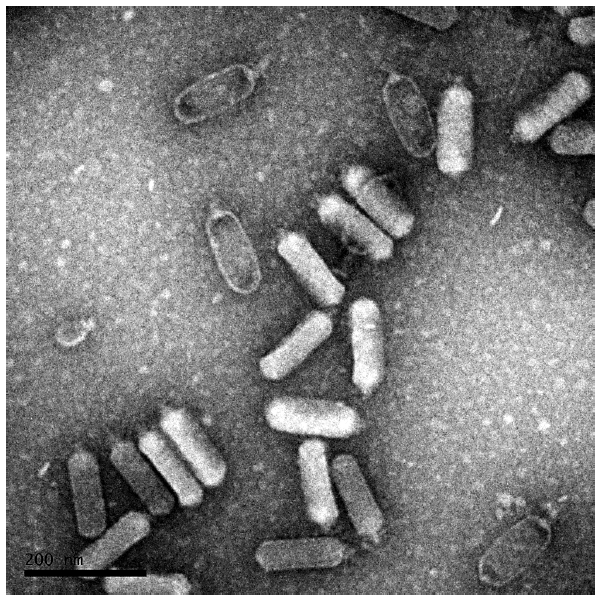
Fig. 1. Transmission electron microscopy of negatively stained SU10. Measured head length is 137 ¡ 4.2 nm.